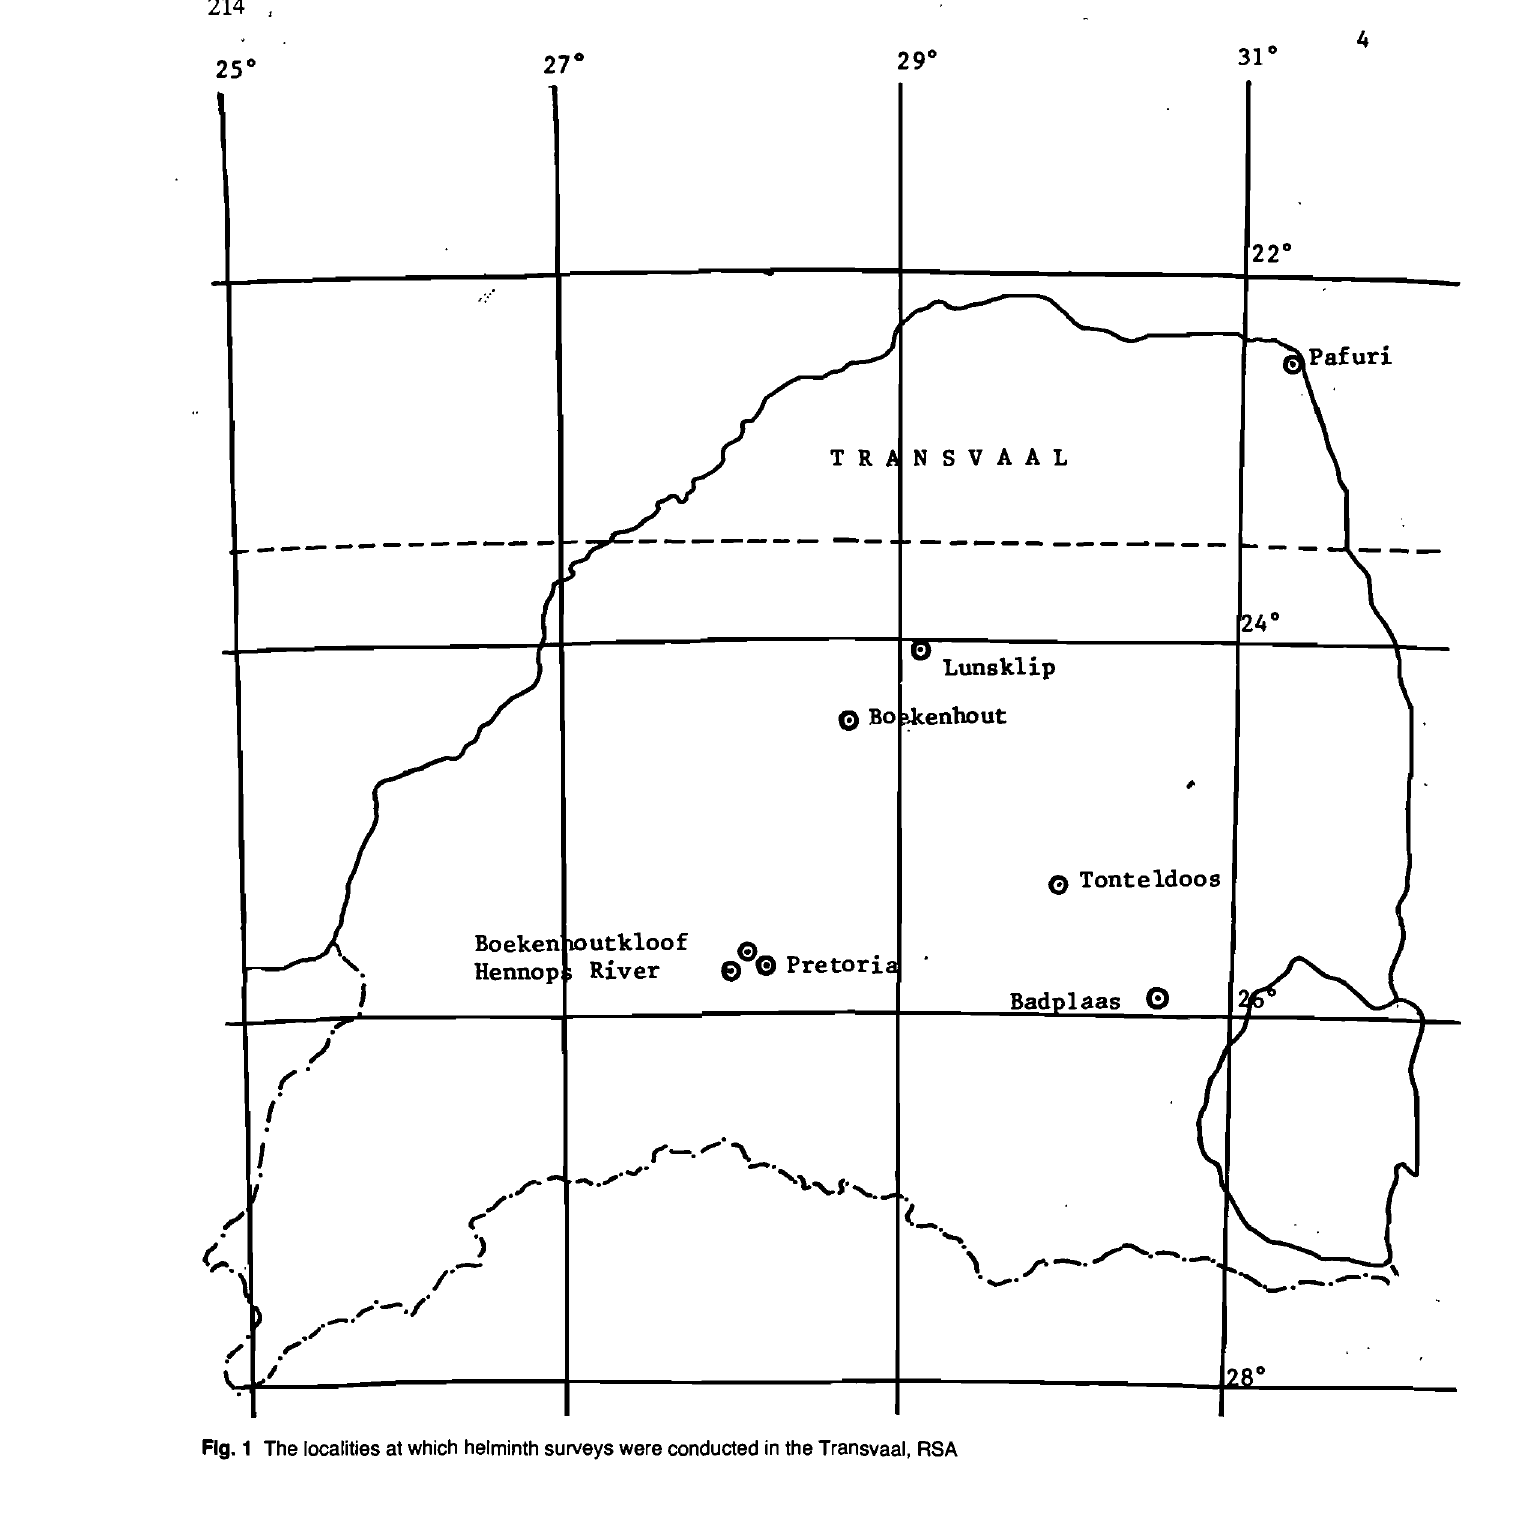
Fig. 1 The localities at which helminth surveys were conducted in the Transvaal,